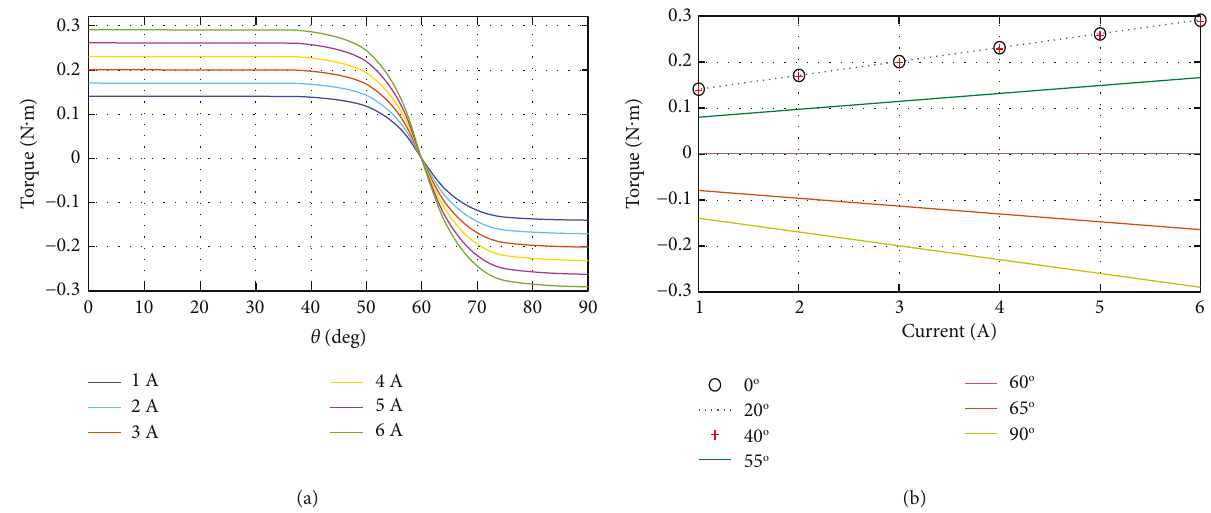
Figure 5: Simulation results of the driving torque characteristics of the joint: (a) torque-angle relationships at different currents and (b) torque-current relationships at different